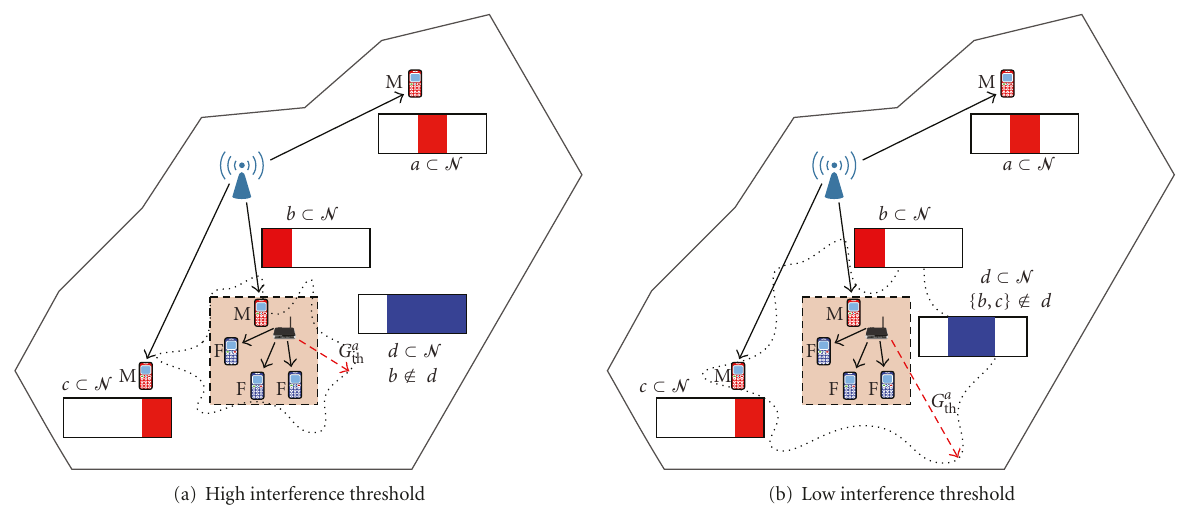
Figure 2: Resource partitioning with two di ff erent thresholds ( G a